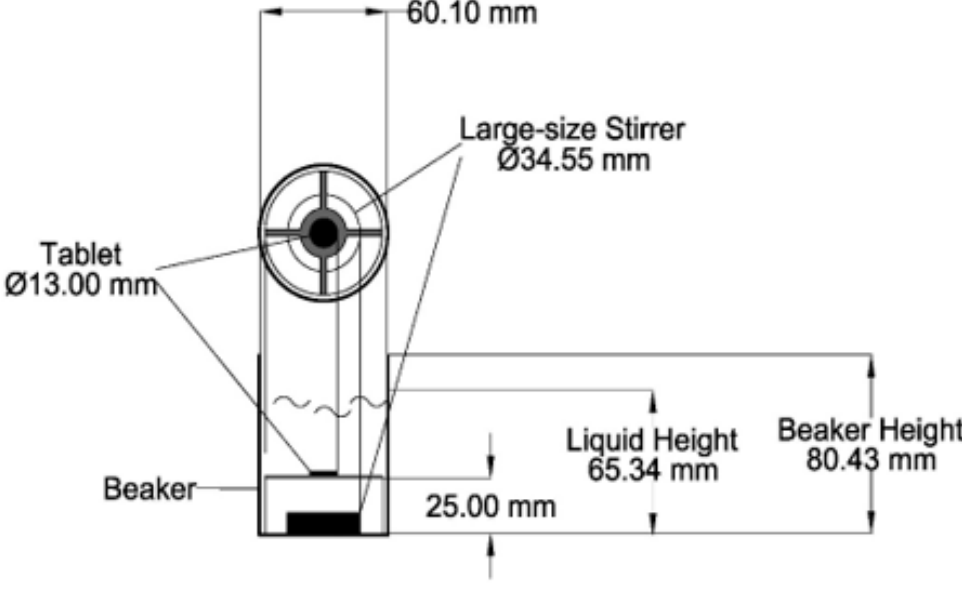
Figure 1. Schematic diagram of beaker and stirrer system.